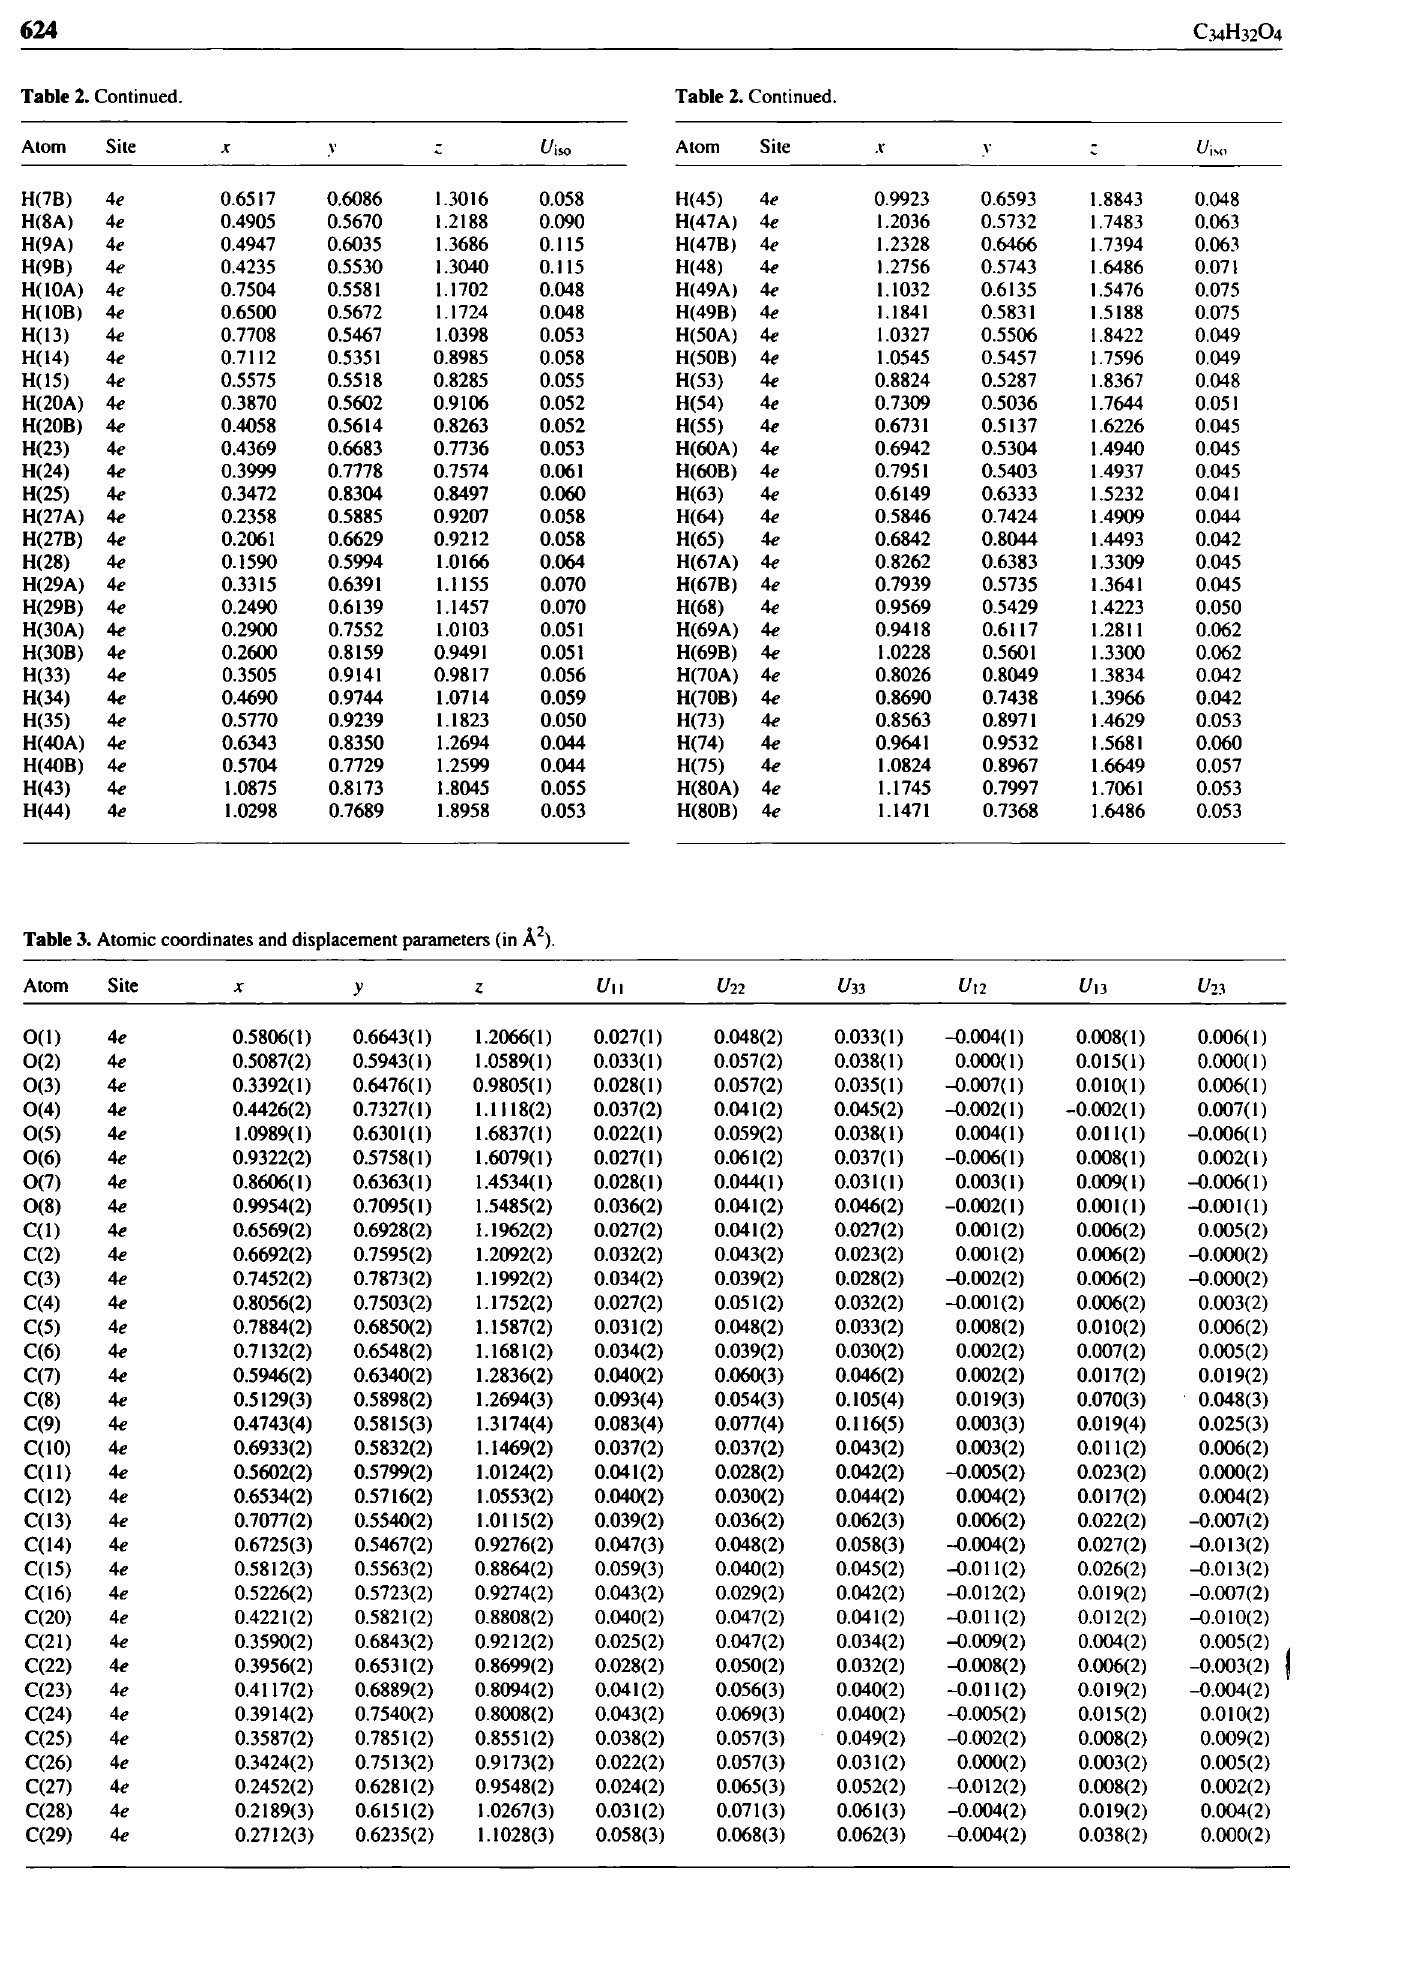
Table 3. Atomic coordinates and displacement parameters (in Ä 2